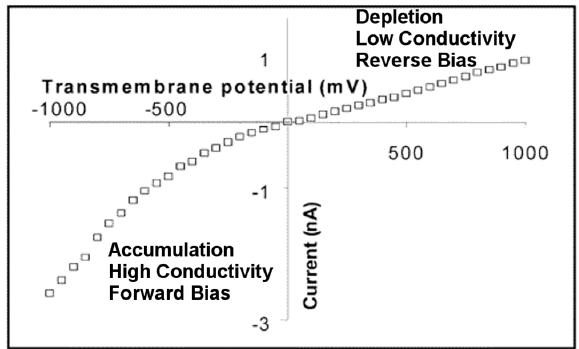
Figure 6. Rectified I-V curve in 0.1 M KCl measured across a PET membrane containing gold conical nanotubes. Reproduced with permission from [16]. American Chemical Society, 2004.